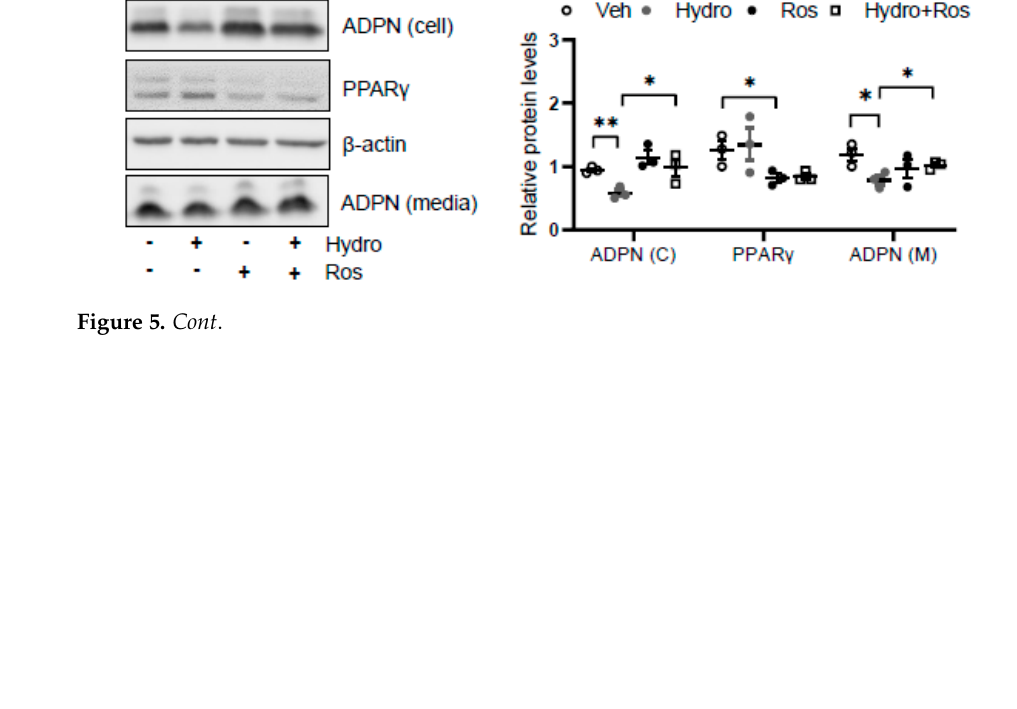
Figure 5. Glucocorticoid receptor signaling suppresses adiponectin expression by inactivating PPAR γ . ( A ) The suppressing effects of GCs on adiponectin expression was attenuated by PPAR γ agonist rosiglitazone in differentiated 3T3-L1 adipocytes. Cells were treated with 2 μ M rosiglitazone for 1 h followed by the co-treatment of 2 μ M hydrocortisone for 24 h. ( B ) The statistical analysis of the results in Figure 5A. White dots, vehicle group ( n = 3); gray dots, hydrocortisone group ( n = 3);